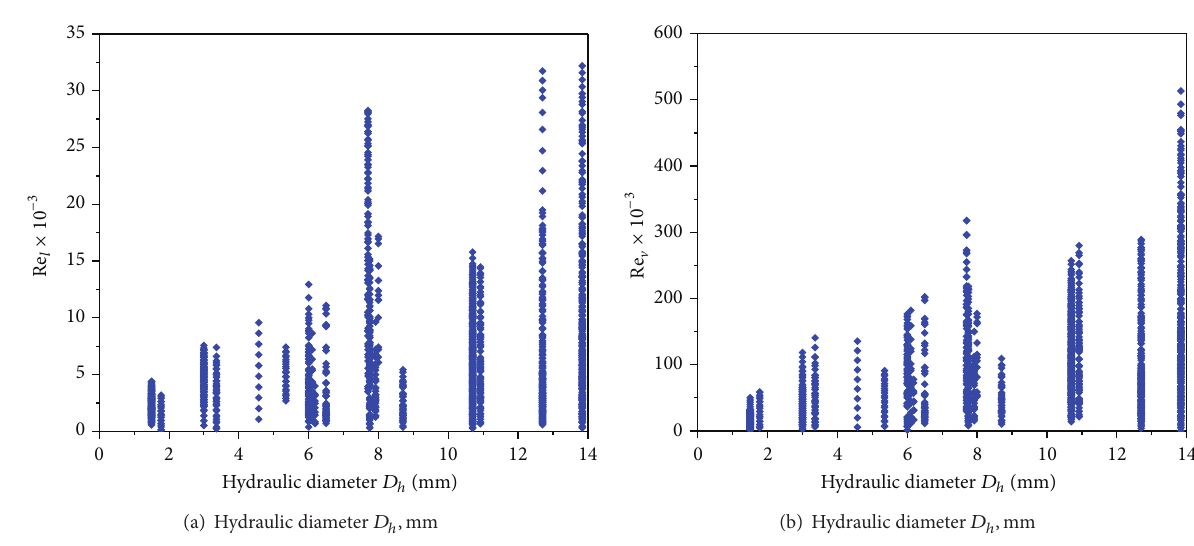
Figure 1: Distribution of channel size with Reynolds numbers